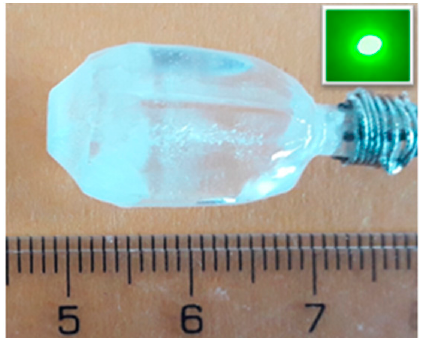
Figure 5. LYSB crystal grown from initial melt composition La 0.765 Y 0.485 Sc 2.75 (BO 3 ) 4 . The figure in the inset shows the LYSB crystal generating green light via SHG. (Reprinted with permission from ref. [13], copyright 2019 American Chemical Society).